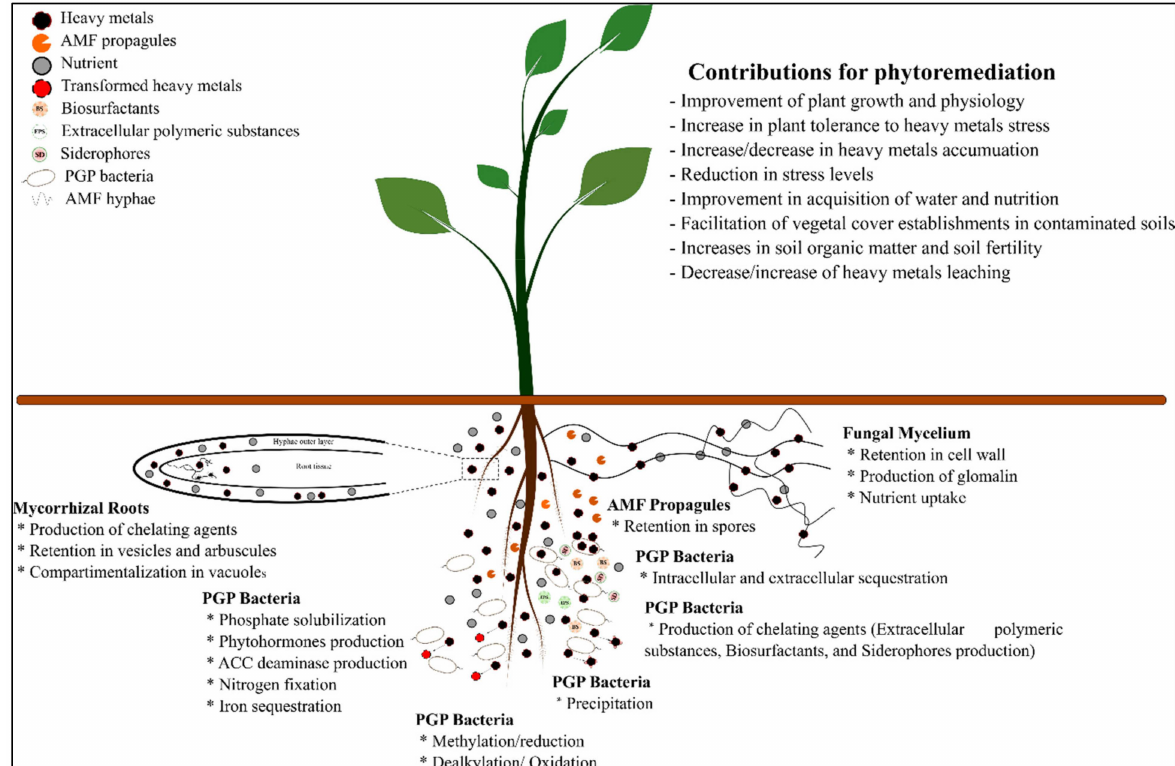
Figure 3. Microbial-assisted phytoremediation for heavy metal decontamination of polluted